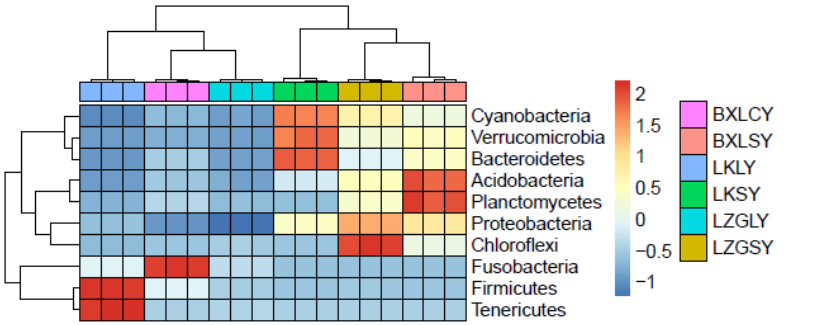
Figure 2. Heatmap of bacterial composition diversities in different samples (phylum level). BXLCY, LKLY and LZGLY were fish gut content sample groups of BXL, LK and LZG fish farm, respectively. All water sample groups were named as LKSY, BXLSY and LZGSY.